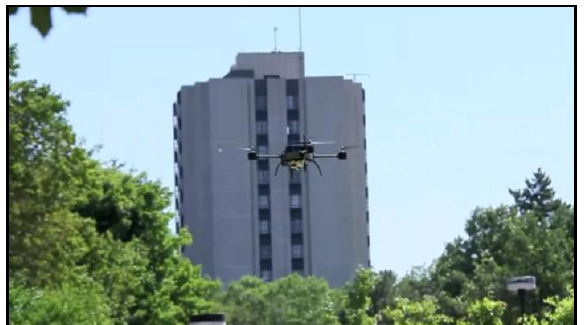
Figure 2. The Aeryon Scout UAS in York University (GEOICT and Elder Laboratory, 2012)